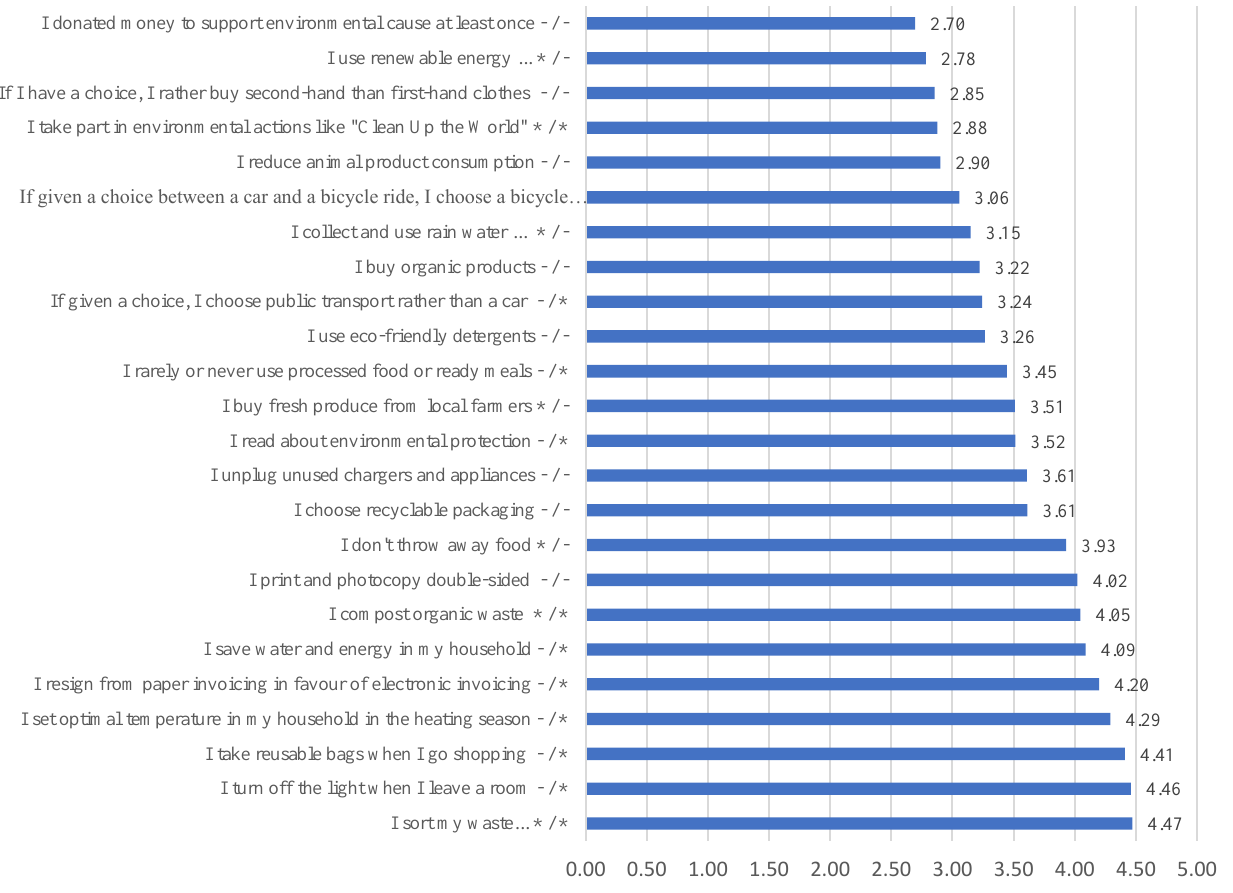
Figure 1. Pro-environmental behaviors declared by the respondents (average of 5-point Likert scale, where 1 — never and it is not important, 2 — never, although I know it ’ s important, 3 — sometimes, 4 — often, 5 — always; the averages do not include the division into groups presented in the article). The asterisks before the slash indicate the relationship (measured with the Pearson chi-square test) between the behavior and the place of residence; asterisks after a slash indicate the relationship between the behavior and the age group; * dependence at the level <0.05; - no relationship was found.